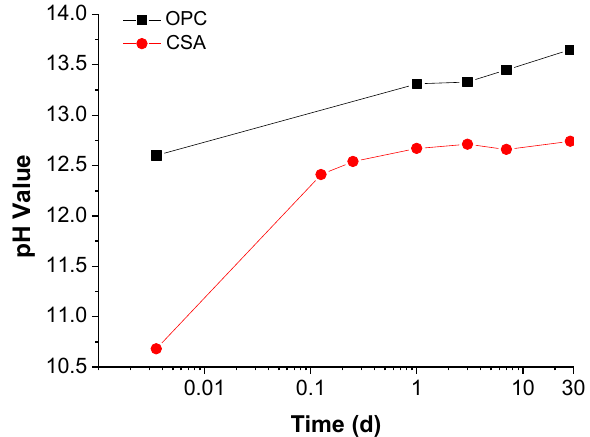
Figure 1. Pore solution pH development for CSA and OPC.